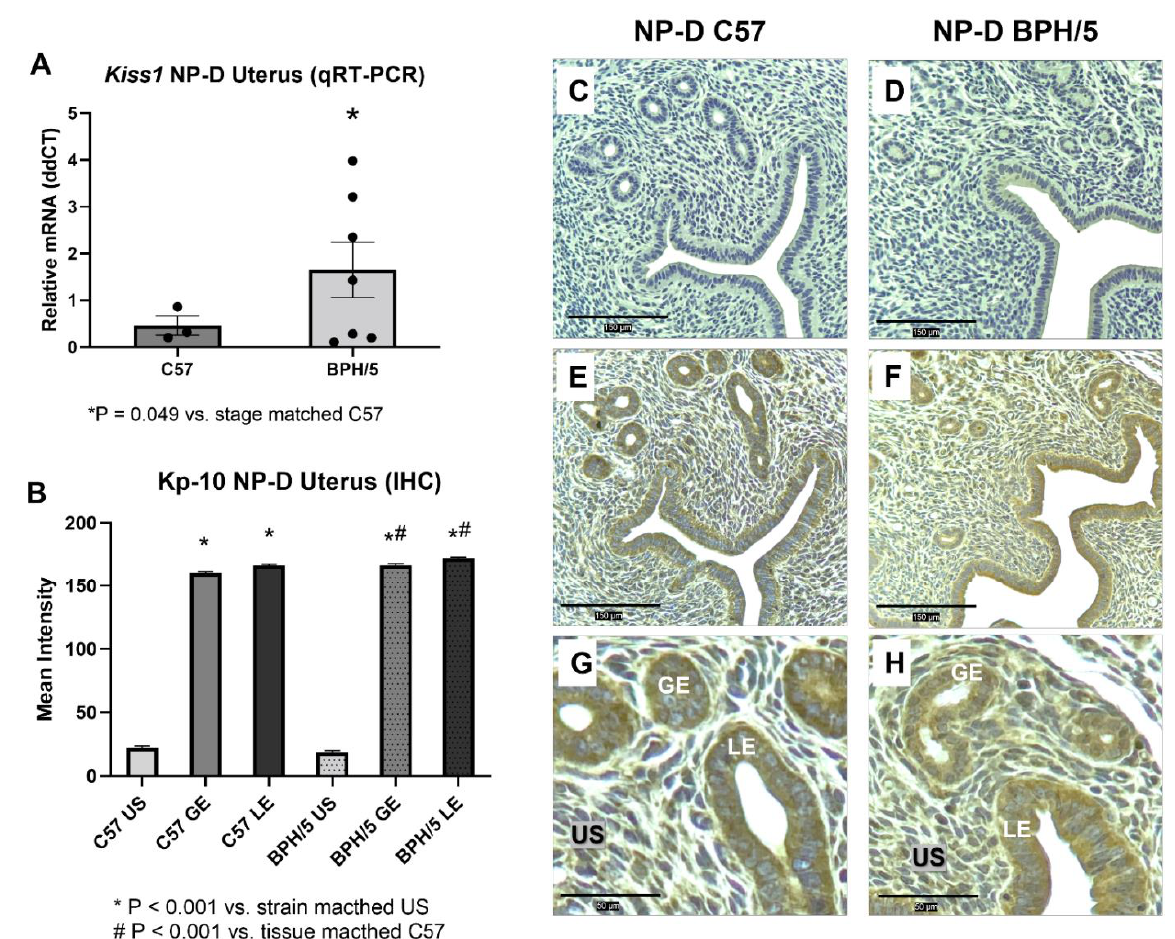
Figure 2. Kisspeptins are upregulated in the BPH/5 non-pregnant uterus during diestrus. ( A ) Quan- tification of Kiss1 gene expression in the non-pregnant diestrus (NP-D) uterus via qRT-PCR ( n = 3 – 7 females/group). Student’s t -test, * p = 0.049 vs. estrous cycle stage matched C57. ( B ) Quantification of mean cytoplasmic immunohistochemical staining intensity of kisspeptin-10 (Kp-10) in the uterine stroma (US), glandular epithelium (GE) and luminal epithelium (LE) of BPH/5 and C57 females during NP-D ( n = 3/group). Kruskal-Wallis and post- hoc Dunn’s test, * p < 0.001 vs. strain matched US, # p < 0.001 vs. tissue matched of NP-D C57. Data expressed as mean ± SEM. ( C – H ) Representa- tive images of Kiss1 immunostaining in BPH/5 and C57 NP-D uteri: ( C , D ) Negative control, scale bar = 150 µm; ( E , F ) Kiss1, scale bar = 150 µm; ( G , H ) Kiss1, scale bar = 50 µm.